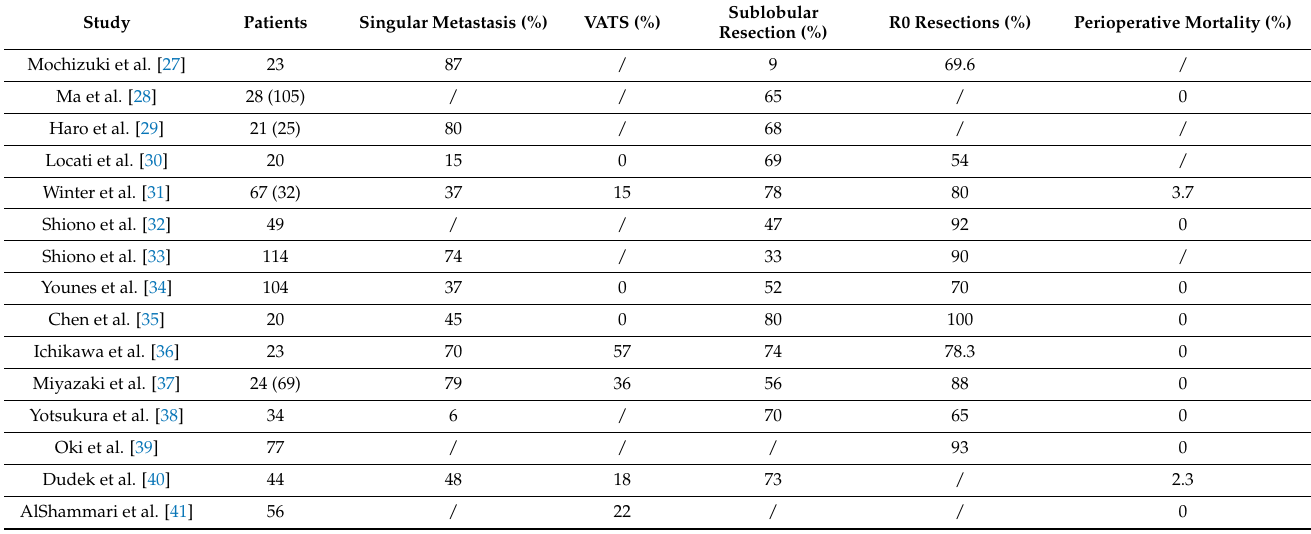
Abbreviations: VATS: Video assisted thoracic